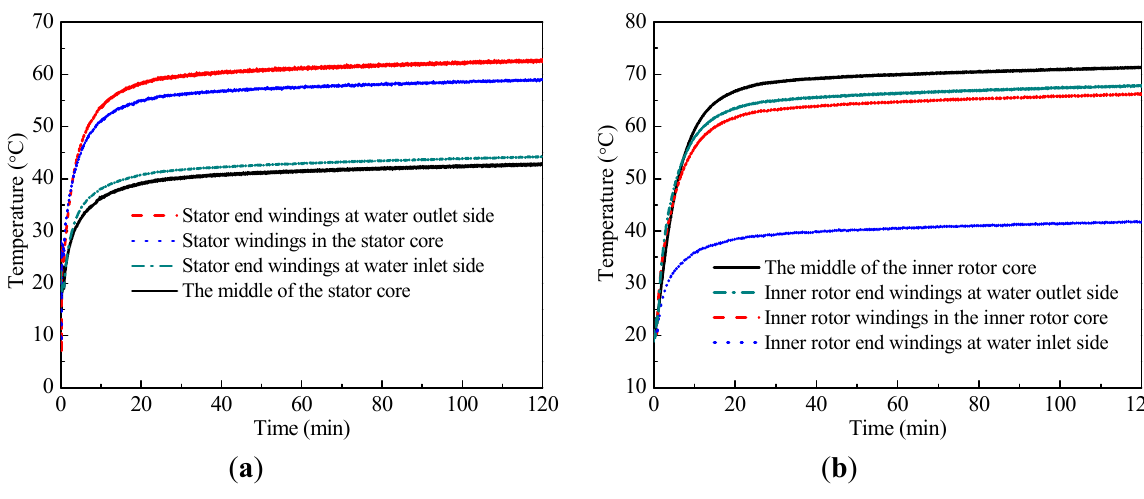
Figure 31. Experimental results when the SM and DRM run at rated torque and rated speed, and water cooling and forced air are used in the machine: ( a ) the SM; and ( b ) the